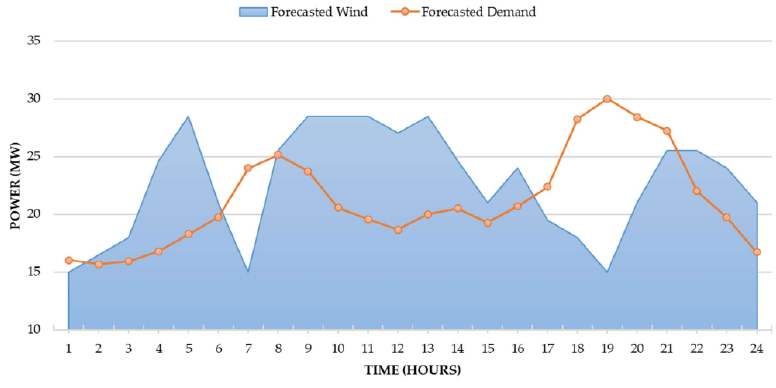
Figure 6. Forecasted wind power and demand.